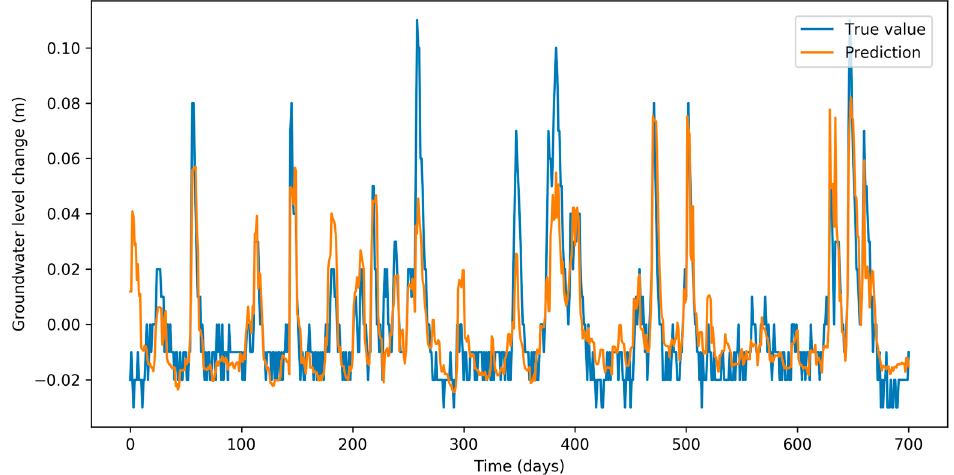
Figure 3. True and predicted groundwater level change based on gradient